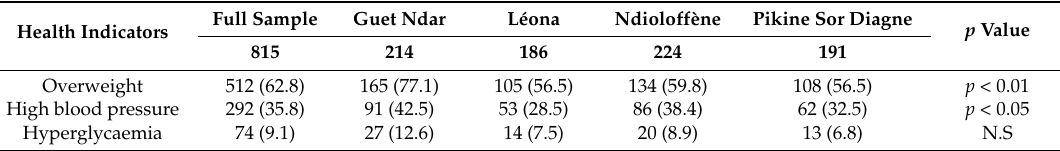
Table 3. Health status of socio-medical survey